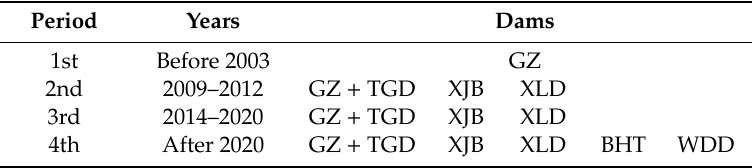
Table 2. The four periods of dam construction on the Yangtze River.